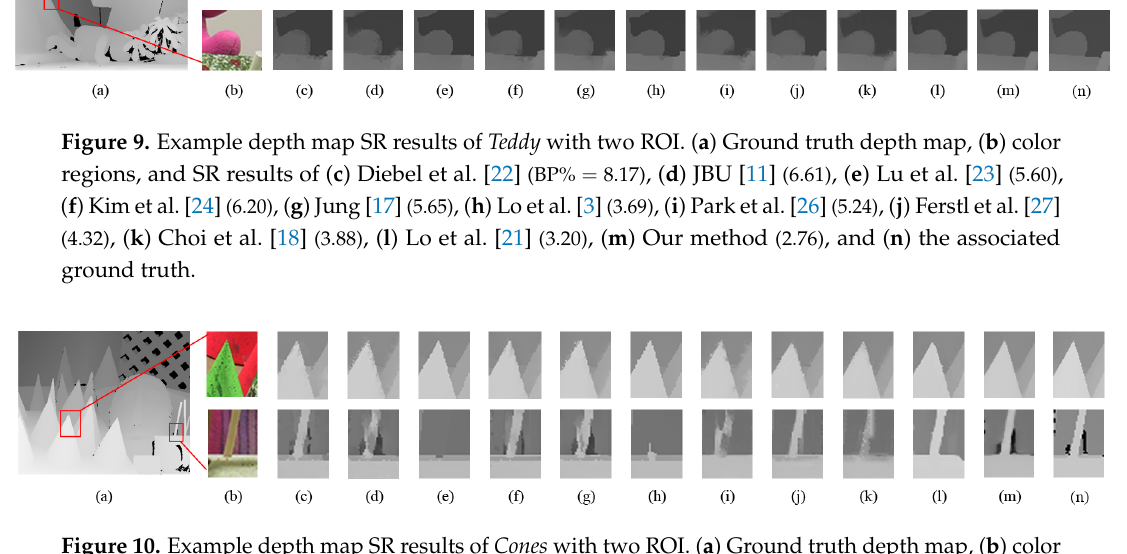
Figure 10. Example depth map SR results of Cones with two ROI. ( a ) Ground truth depth map, ( b ) color regions, and SR results of ( c ) Diebel et al. [22] (BP% = 8.10) , ( d ) JBU [11] (7.54) , ( e ) Lu et al. [23] (4.51) , ( f ) Kim et al. [24] (5.33) , ( g ) Jung [17] (5.93) , ( h ) Lo et al. [3] (3.82) , ( i ) Park et al. [26] (5.73) , ( j ) Ferstl et al. [27] (3.44) , ( k ) Choi et al. [18] (5.52) , ( l ) Lo et al. [21] (3.19) , ( m ) Our method (2.58) , and ( n ) the associated ground truth.